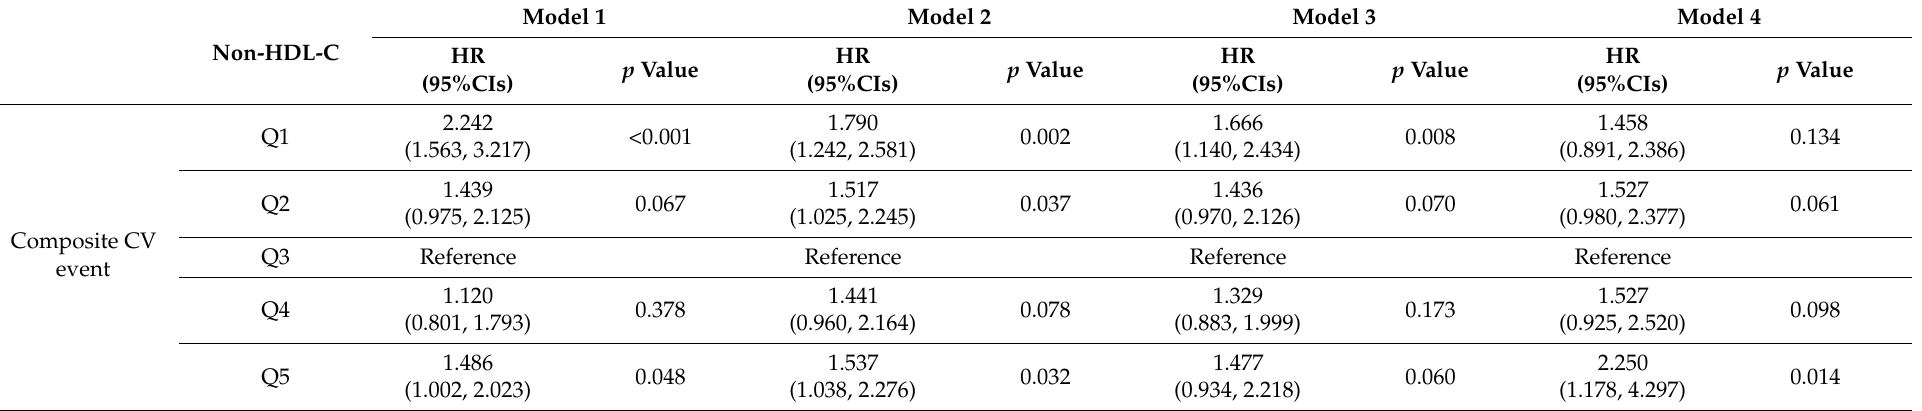
Table 4. Cause-specific HRs for the primary outcome by non-HDL-C level.